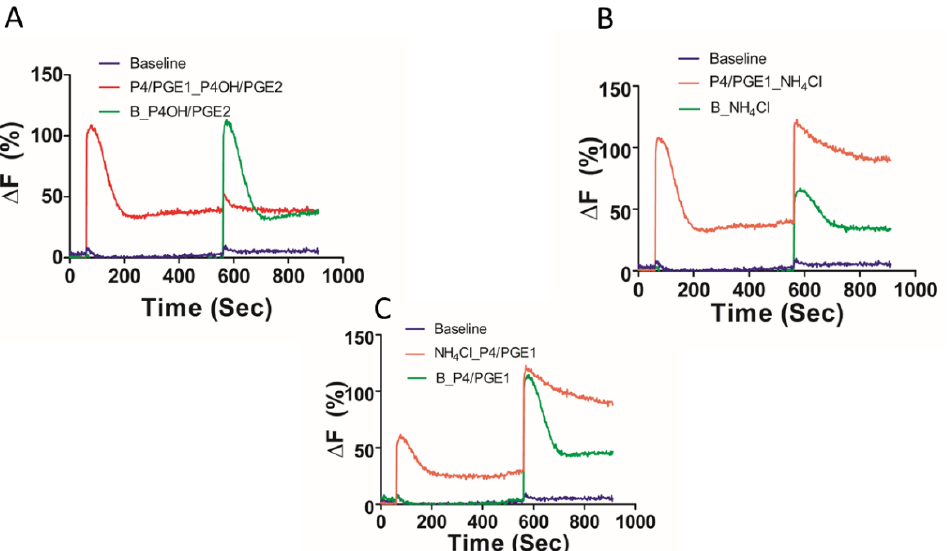
Figure 9. Asynchronous application of NH 4 Cl can sustain the [Ca 2+ ]i response to progesterone and prostaglandin E1. Population mean [Ca 2+ ]i traces ( n = 5) showing initial agonist addition of either a saturating concentration of 10 μM progesterone (P4) or 5 μM PGE1 ( A , B ) or 30 mM NH 4 Cl ( C ) followed by a second agonist challenge. Baseline control (HTF, shown in blue) was included in each experiment. Addition of time control for the second agonist challenge is shown in green. A. Cross- desensitization of P4 and PGE1 responses. ( B ). Reactivation of CatSper following desensitization is achieved by additional of NH 4 Cl in the presence of P4/PGE1. ( C ). An elevated and sustained [Ca 2+ ]i response to P4/PGE1 is achieved with pre-application of NH 4 Cl.